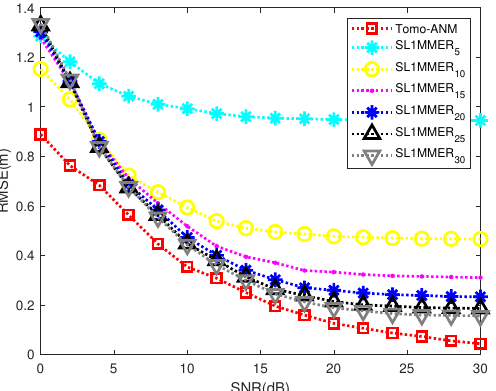
Figure 7. Location accuracy (RMSE) of single scatterer under different SNRs. Detection Rate : The detection rate of the two scatterers using Tomo-ANM and SL1MMER was studied. The SNR was set to 0:2:30 dB, the grid density was set to num = 20, 30, and the distance between the two scatterers was set to k s = 0.2:0.1:1.5. The elevation was randomly distributed in [ 0, H ] , and the amplitudes and phases were equal and fixed. We first judged whether the number of scatterers was consistent with the fact. On the premise that the number of scatterers is correct, RMSE < threshold is regarded as a successful recovery; otherwise, recovery fails. In this paper, threshold = 1 m, which is nearly 1/19 ρ s . Monte Carlo experiments were performed 1000 times for each parameter setting, and the times of successful recovery were recorded to obtain the detection probability graph shown in Figure 8. The slight drop in the detection rate around k s = 1 is caused by the interference of the two strong scatterers. The interference effect becomes stronger when the amplitude of the scatterers becomes closer [30]. As we can see, with a higher grid density, SL1MMER 30 performs slightly better than SL1MMER 20 . The most striking difference is that, when K s = 0.9 and SNR = 30 dB, the detection rate of SL 1 MMER 20 is 72.8%, while that of SL 1 MMER 30 is 94.8%. Compared to the better-performing SL 1 MMER 30 , the detection rate of Tomo-ANM is higher than SL1MMER regardless of the K s and SNR . For example, the detection rate of SL 1 MMER 30 is only 26.5%, while that of Tomo-ANM is 77.6% when K s = 1 and SNR = 24 dB. When K s = 1.1, Tomo-ANM can achieve a detection probability of more than 90% when the SNR is greater than 20 dB, while SL 1 MMER 30 needs an SNR greater than 24 dB to achieve the same performance. When K s = 1.2, Tomo-ANM can achieve a detection probability of more than 90% with an SNR greater than 14 dB,